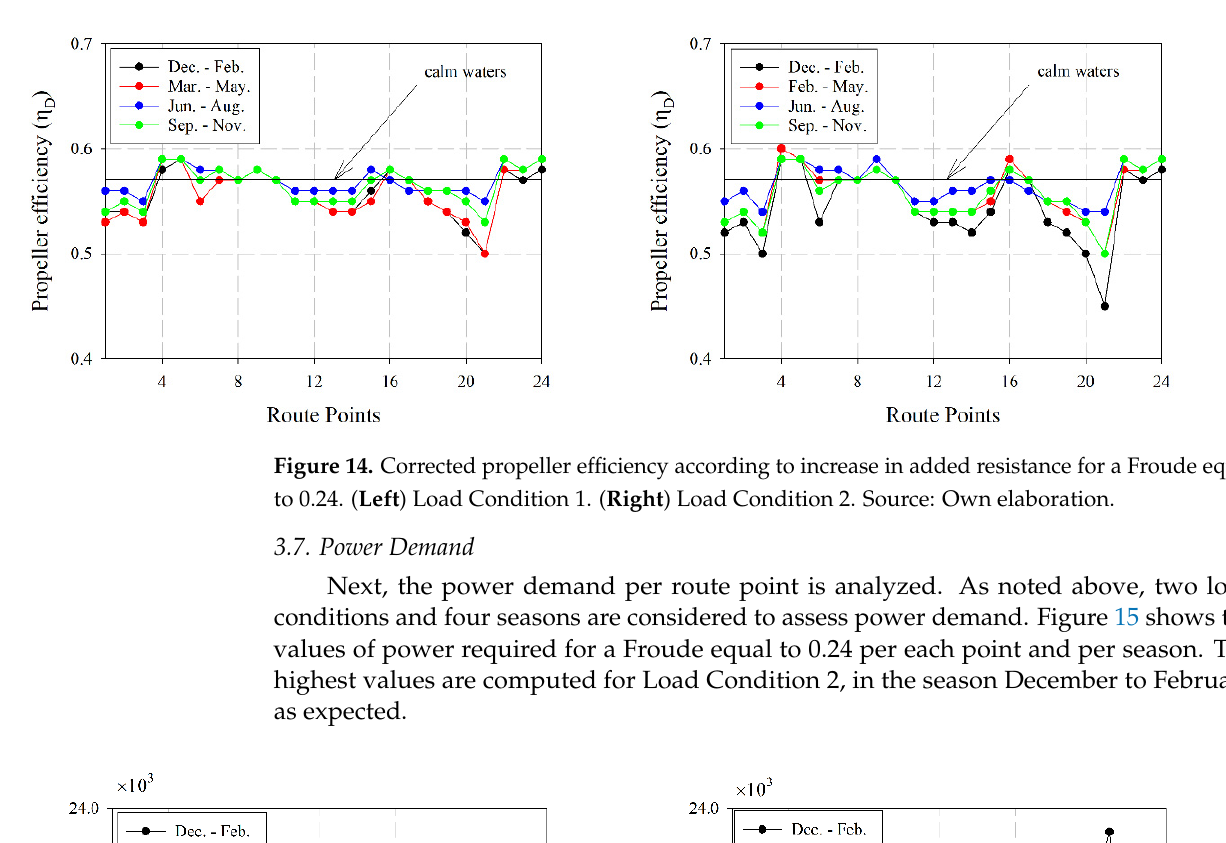
Figure 15. Power demand in each route point per load condition and per season. (Left) Load Con- dition 1. (Right) Load Condition 2. Source: Own elaboration.